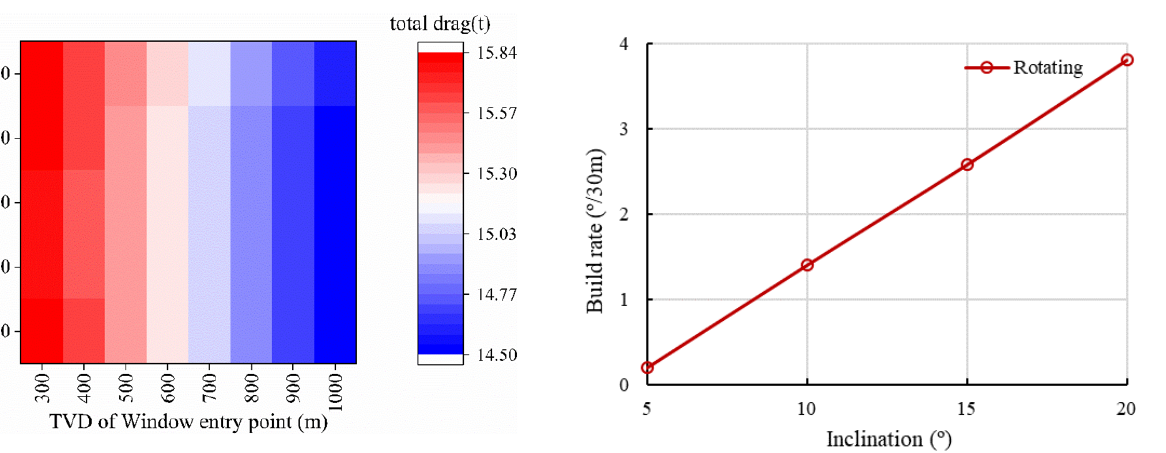
Fig. 11. Rotating build rate VS inclination for BH-PDM-S